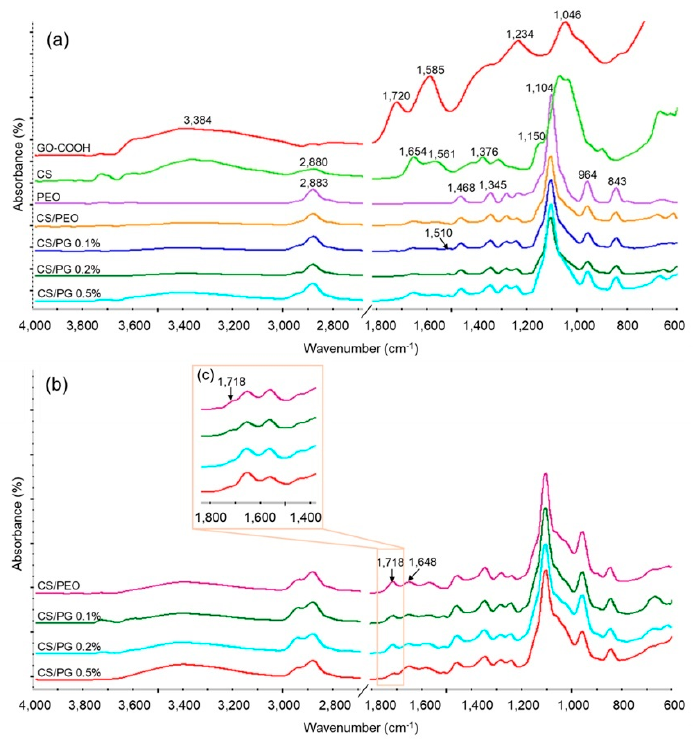
Figure 2. ATR-FTIR spectra of ( a ) raw materials and all un-crosslinked electrospun scaffolds; ( b ) unwashed crosslinked samples (characteristic free-aldehydic peak); and ( c ) 5 days washed crosslinked nanofibrous scaffolds.